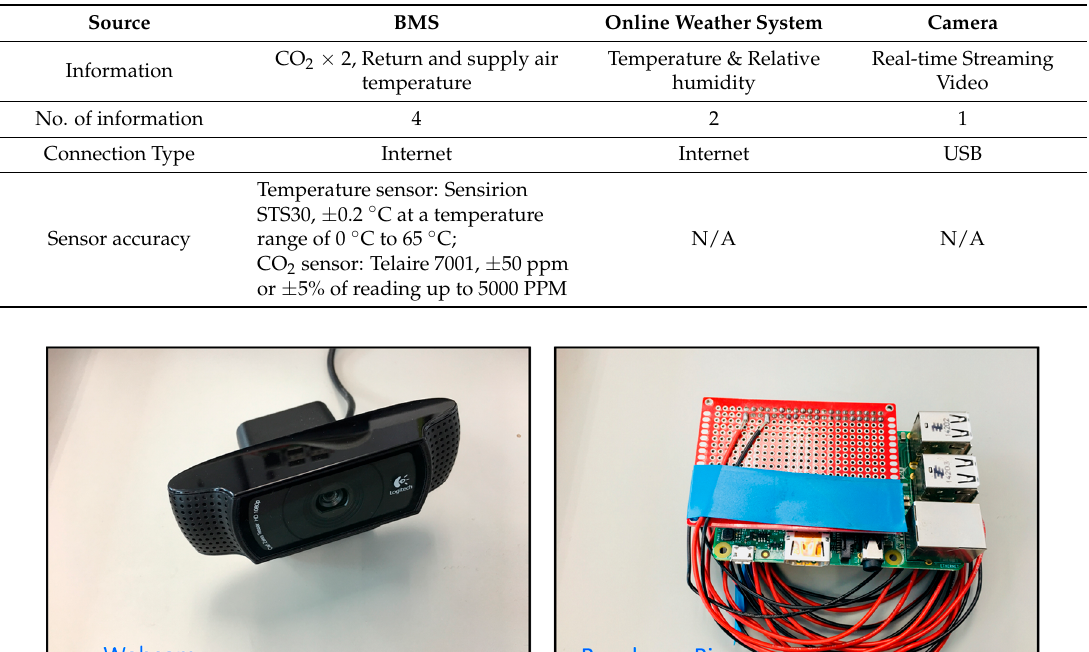
Table 4. Summary of data collected.